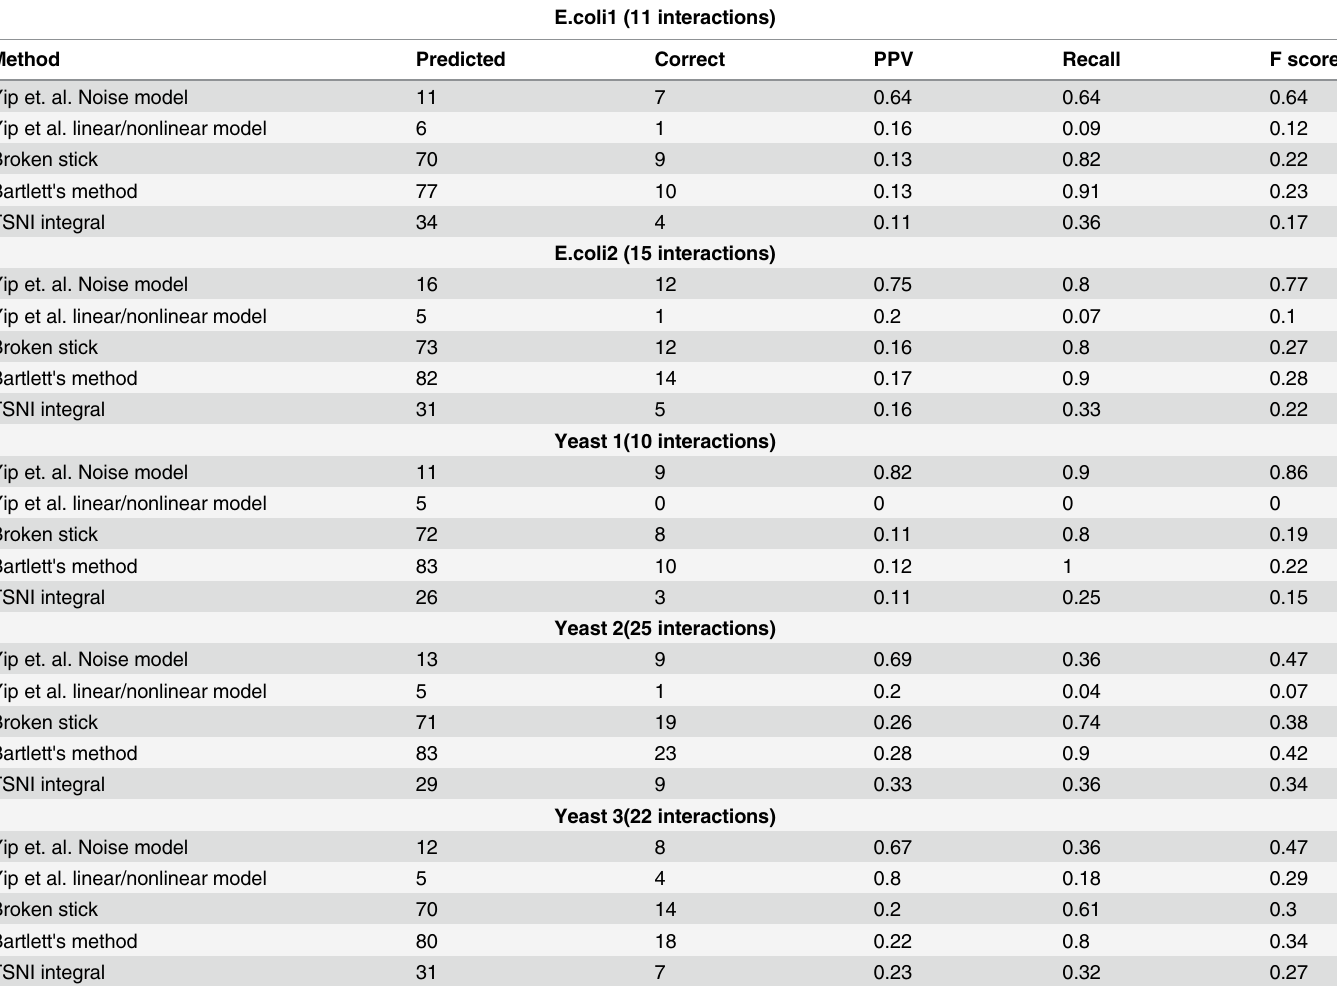
Table 4. Recovering a 10-node network from a DREAM-3 data